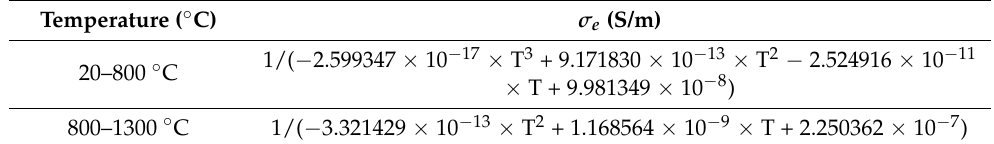
Table 1. Electrical conductivity function.